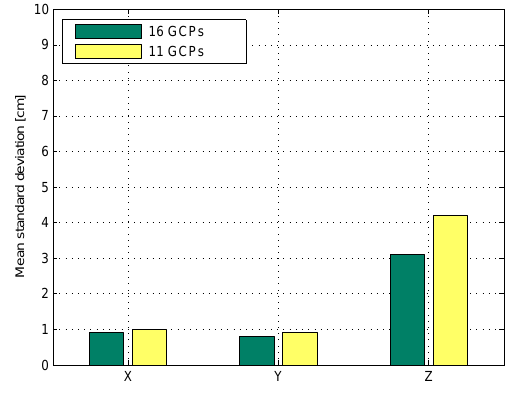
Figure 12: Mean standard deviations of tie points in object space regarding two different GCP